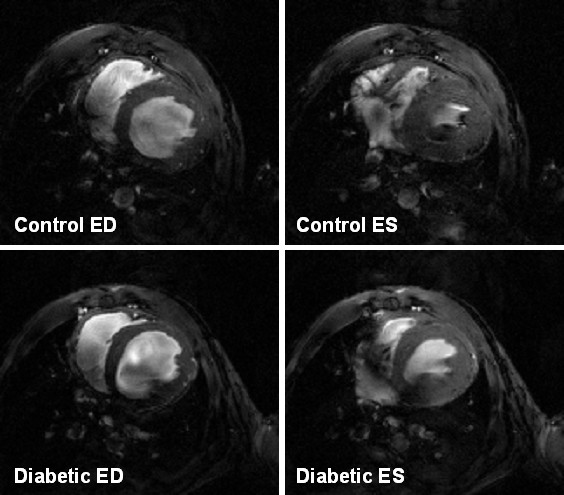
End-diastolic (left) and end-systolic (right) MR images in a mid-ventricular slice from a control (top) and diabetic (bottom) mouse. The LV diameters for the control and diabetic mouse were similar at end diastole (ED), but apparently increased at end systole (ES) for the diabetic mouse heart compared with control. The wall thickness at both end diastole and end systole in the diabetic mouse heart was decreased compared with control.